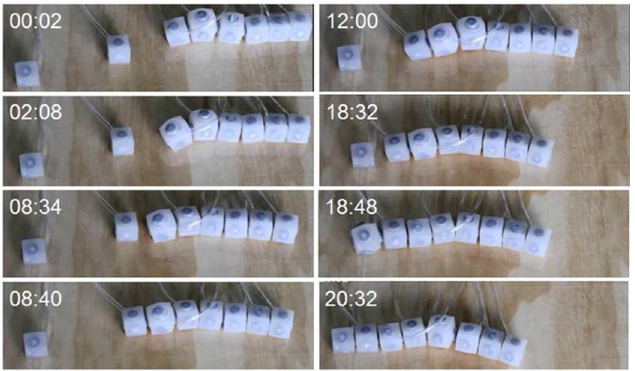
Fig 4. Cell adhesion during collective migration. A sequenceof images displayinghow a group of six connectedmodulesis able to travel (from right to left) thanks to the coordinatedinflation of modules.At time t = 8m:40s an adhesion occurs resultingin a new module incorporatedto the group. The new seven-element robot continuestravelling sideways until a new moduleadheresat t = 18m:48s. Then the resultingeight- elementrobot continuesmoving